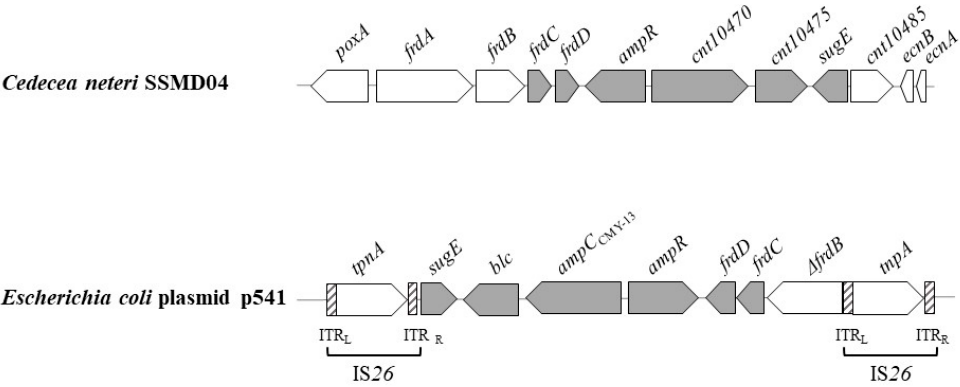
Figure 2. Genetic environment of the JT31_10470 ( cnt10470 ) locus on the C. neteri SSMD04 chromosome compared to the ampC CMY-13 locus on the E. coli plasmid p541 [50]. Shared genes with similar annotated functions are displayed in gray.